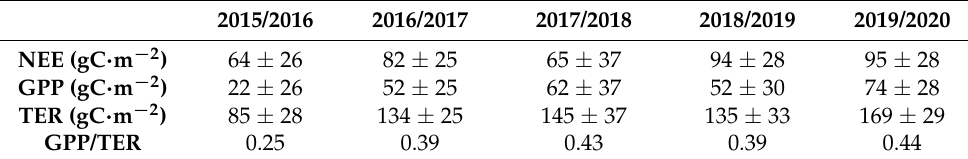
Table 4. Winter (1 November–31 March) sums of net ecosystem exchange (NEE), gross primary production (GPP), and total ecosystem respiration (TER) with uncertainty estimates associated with random error in the measured fluxes. u*—threshold estimation, gap-filling, and flux partitioning procedures ( ± SD), as well as GPP/TER ratio at the nemorose spruce forest in the 2015–2020 period.